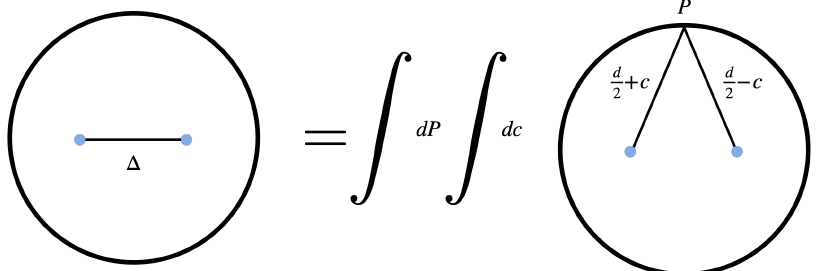
Figure 4 . An illustration of the split representation. The bulk-to-bulk propagator can be written as a product of bulk-to-boundary propagators integrated over the boundary point and the spec- tral